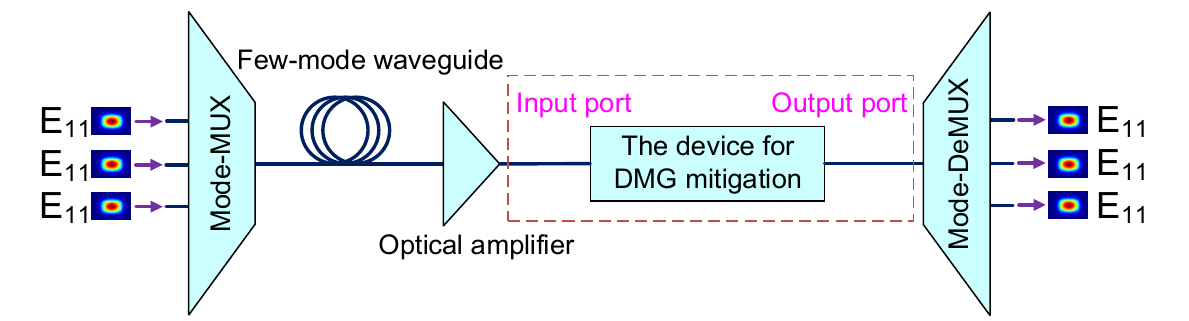
Figure 12. MDM transmission system with DMG mitigation.